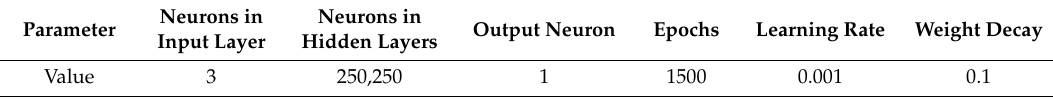
Table 2. Processing parameters for the neural